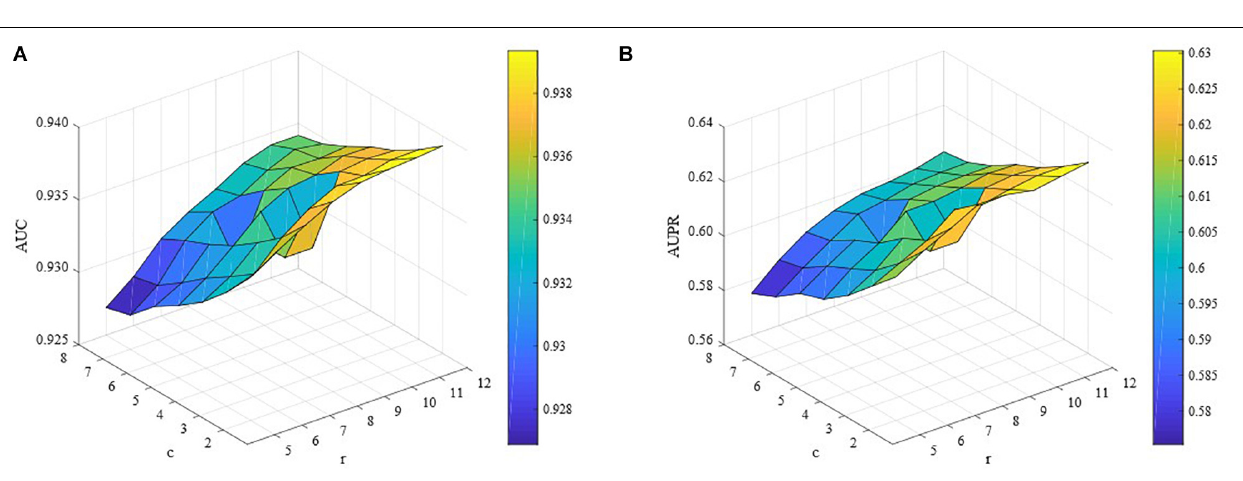
FIGURE 3 | Performance of ILMF on “DrugMetaboliteAtlas” dataset with different values of c and r . (A) AUC versus c and r ; (B) AUPR versus c and r